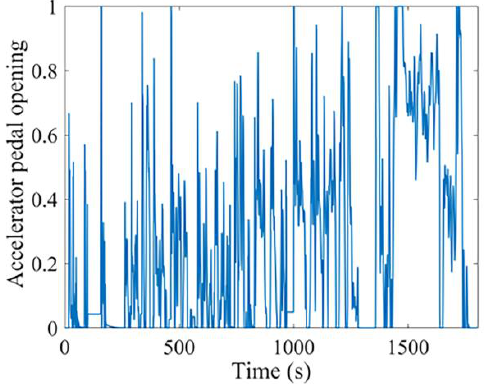
Figure 13. AP opening.